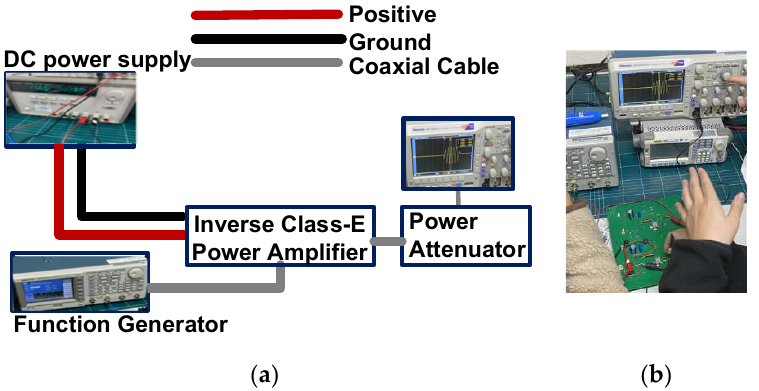
Figure 5. ( a ) Measurement setup and ( b ) photo for the performance of the designed inverse Class-E power amplifier. Figure 6a,b show the measured output voltage or voltage gain versus the input volt- age of the designed inverse Class-E power amplifier. The function generator yielded 10- MHz input voltage signals in the 0.4–3.6 V range, with increments of 0.3 V. The voltage gain and voltage gain difference were calculated using Equations (12) and (13), respec- tively, as follows: